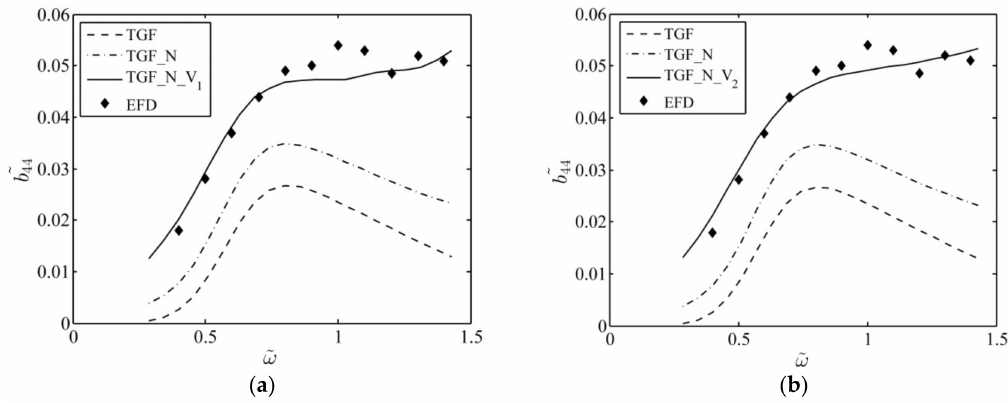
Figure 4. Equivalent roll damping using different methods (TGF [25], TGF_N [25], TGF_N_V ) as compared with experimental fluid dynamic (EFD) data [13,26]. ( a ) Equivalent roll damping related to the first viscosity distribution approach; ( b ) Equivalent roll damping related to the second viscosity distribution